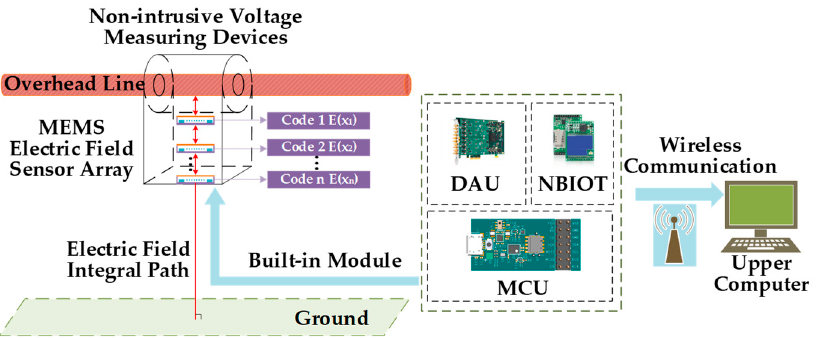
Figure 6. The overhead-line-voltage monitoring system based on the near-end electric-field integra- tion